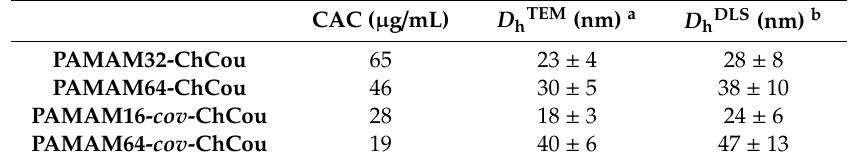
a Average size diameter obtained by TEM from 200 individual micelles. b Average size diameter obtained by DLS from number size distributions.